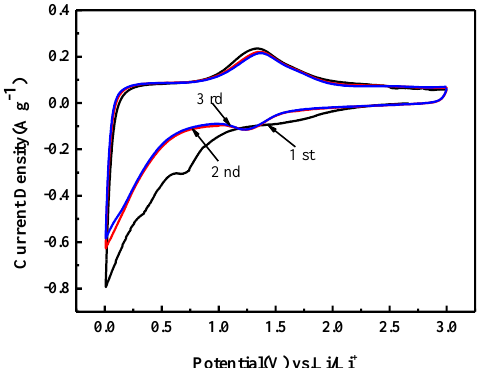
Figure 6. CV curves of MON-QD/NG-600 composite material.